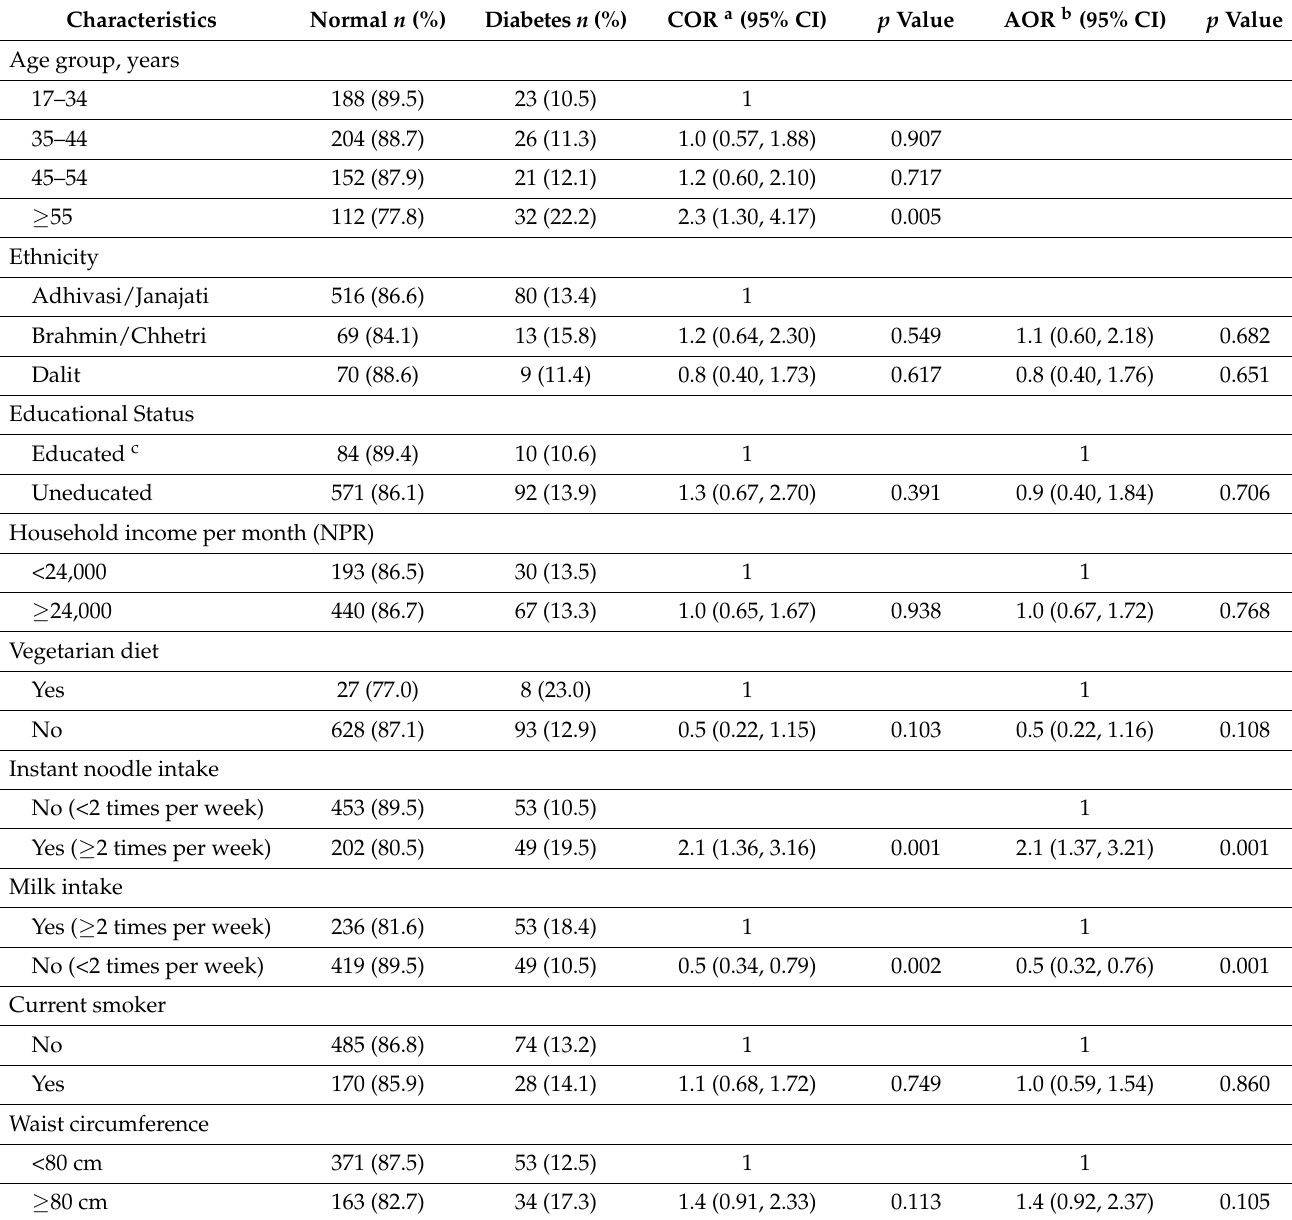
Table 3. Risk factors associated with diabetes in the study